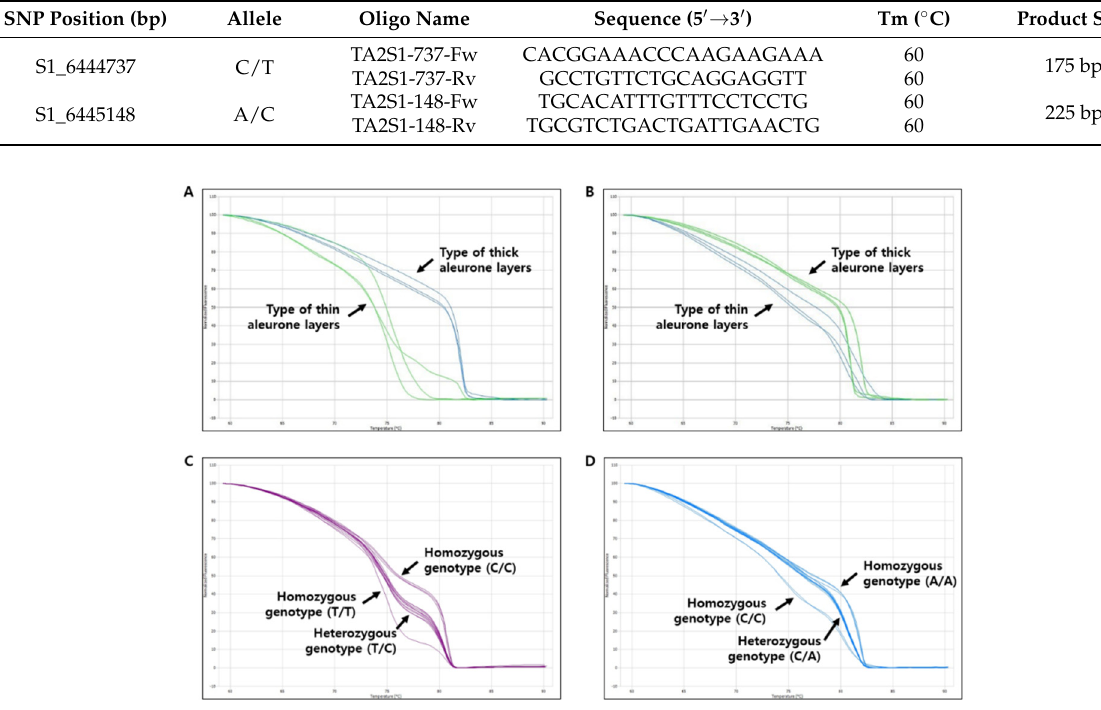
Figure 8. Validation test of the two HRM markers, TA2S1-737 ( A , C ) and TA2S1-148 ( B , D ), using the melting curves developed in this study. In A and B, three resources (RWG092, RWG224, and RWG292) with thick aleurone layers and three resources (RWG040, RWG053, and RWG072) with thin aleurone layers were used, respectively. In C and D, 50 individuals that crossed “Samgwang” (thick seed coat and aleurone layers) and “Seolgaeng” (thin seed coat and aleurone layers) were used, respectively. Table 5. Statistical analysis of the HRM results with backcross population (BC 2 F 2 ) from the cross between Samgwang (variety with a thick aleurone layers) and Seolgaeng (variety with a thin aleu- rone